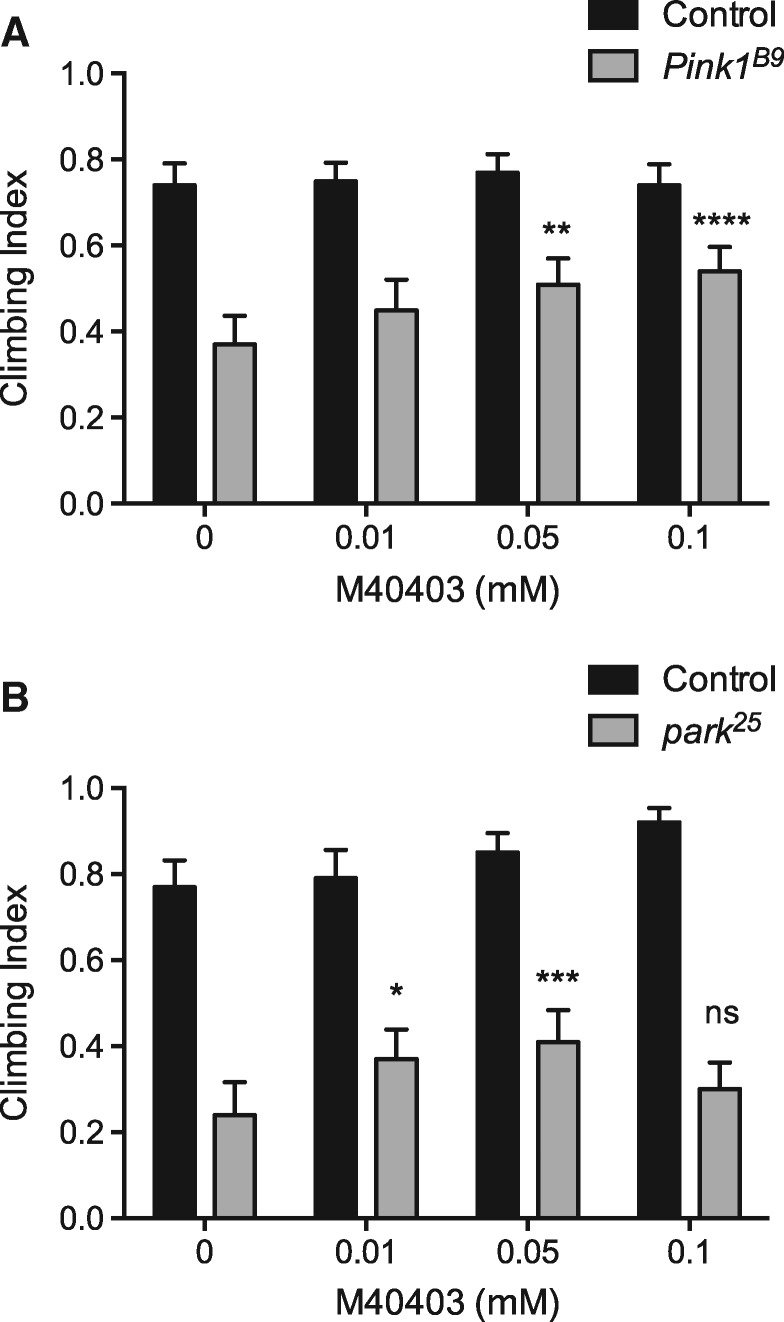
Effect of M40403 on Pink1/parkin mutant motor ability. Climbing assay of (A) Pink1 and (B) parkin mutant flies treated or not with indicated concentrations of M40403. Charts show mean and 95% CI, n > 100 animals. Statistical analysis used two-way ANOVA with Tukey’s multiple comparisons test (*P < 0.05, **P < 0.01, ***P < 0.001, ****P < 0.0001; ns, non-significant).